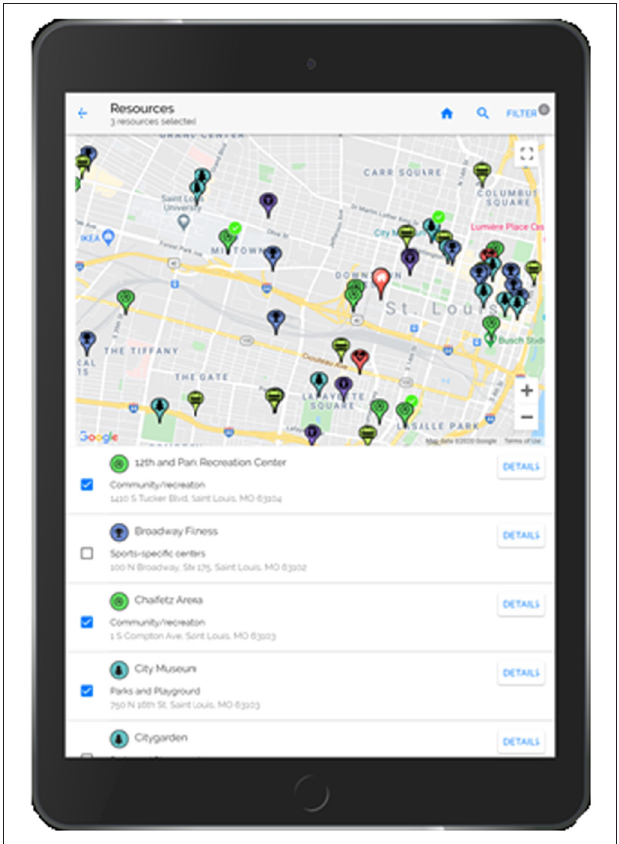
FIGURE 4 | PREVENT tool step 3 community resource